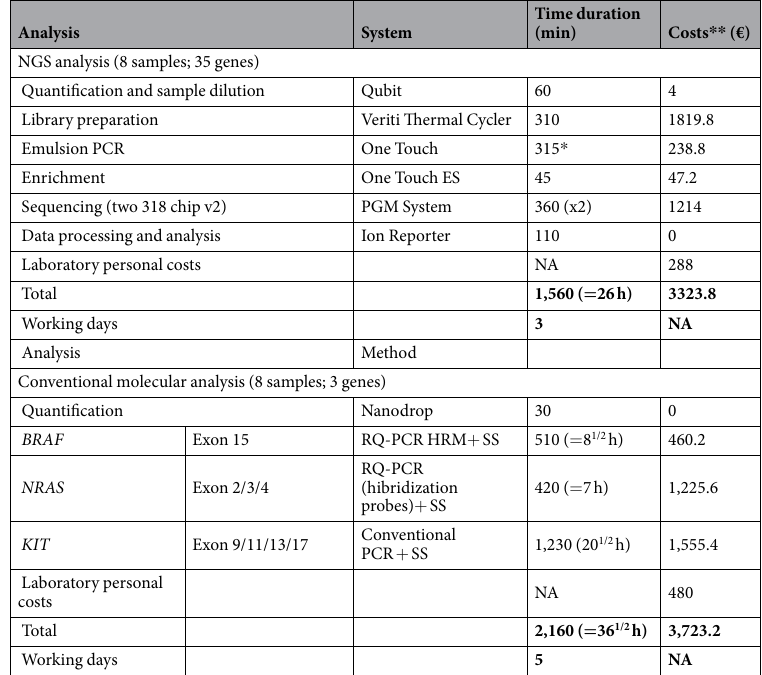
Table 4. Turn-around time and cost comparison between Next-generation sequencing and conventional molecular analysis. NGS: Next-generation sequencing; PGM: Personal Genome Machine PCR: polymerase chain reaction; RQ-PCR: real-time quantitative polymerase chain reaction; SS: Sanger sequencing; HRM: High- resolution melting; NA: Non applicable. * The duration of the second emulsion PCR required is not included as it is done at the same time as the first sequencing run. ** Costs: Cost of consumables and laboratory personal (as cost calculated from the time that the technician/physician is required for the